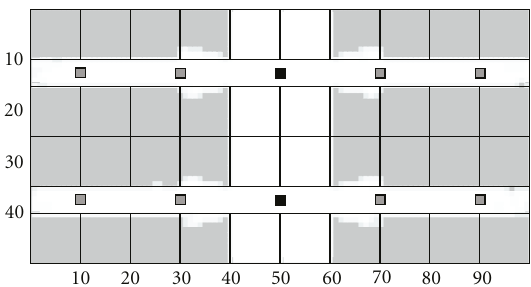
Figure 4: Local area scenario with two BSs (dark gray) and four relay stations (light gray) to assist each